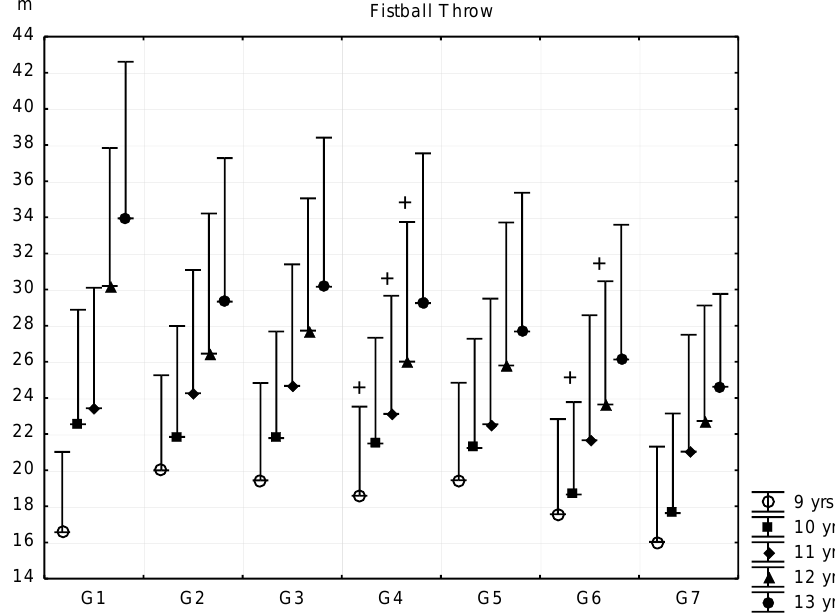
Figure 7. Relationship between body fat percentage and fistball throw (mean + SD). 1—F% < 8.00; 2—F% = 8–11.99; 3—F% = 12.00–15.99; 4—F% = 16.00–19.99; 5—F% = 20.00–23.99; 6—F% = 24.00–27.99; 7—F% > 28; F% body fat percentage; + significant difference in certain consecutive groups, p < 0.05.